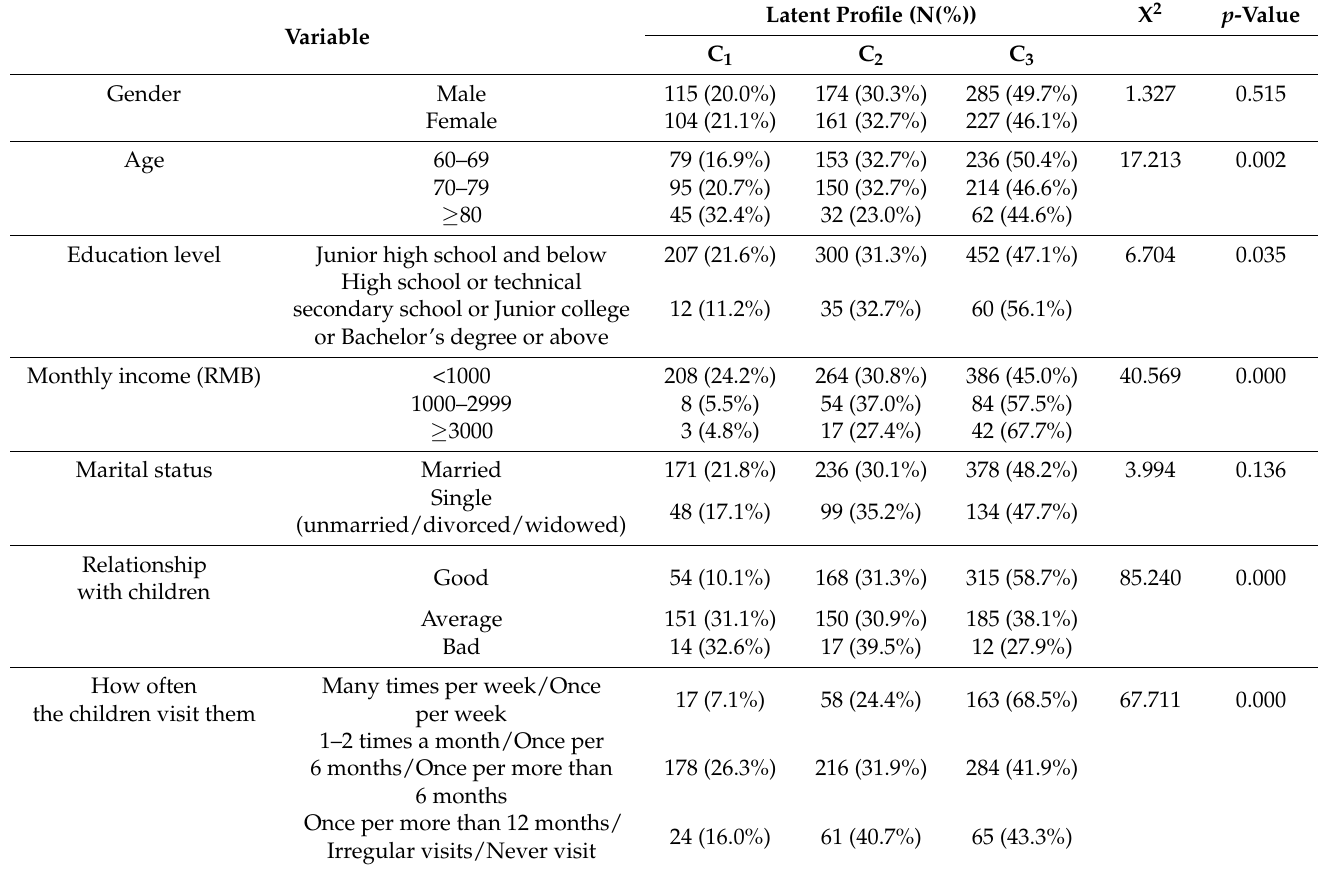
Table 7. Demographic characteristics of the three